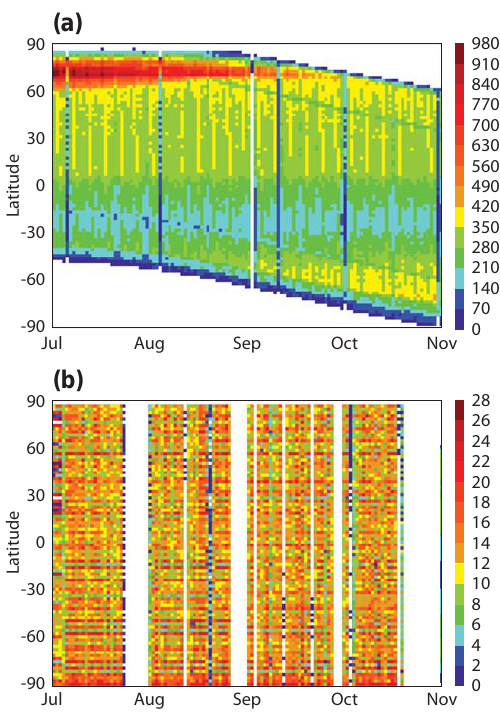
Figure 1. Data coverage and daily count binned in 2 ◦ latitudinal bands for the CCI GOME-2 (a) and the CCI MIPAS (b) data during the period July–October 2008. The two colour scales are different. The colour scale used for GOME-2 (a) varies from 0 (dark blue) to 980 (dark red) observations with a step of 70; the one used for MIPAS ranges from 0 (dark blue) to 28 (dark red) observations with a step of 2.